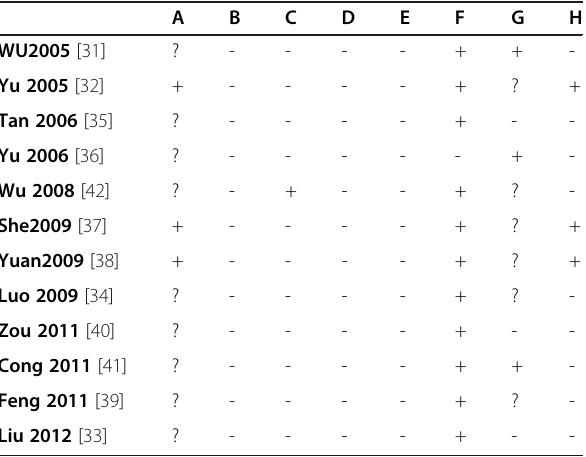
Table 2 The methodological quality of included studies based on the Cochrane